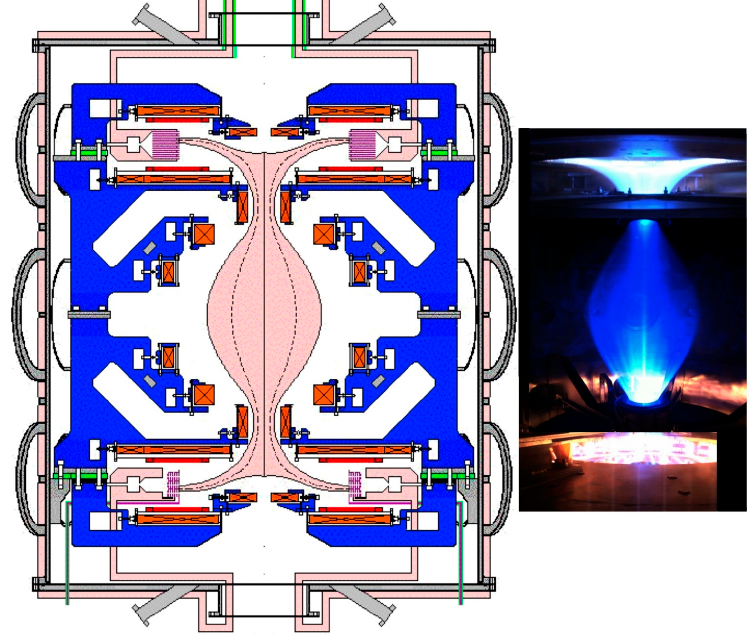
Figure 19. Comparison between the centerpost expected from the calculations and the shape obtained during the experiments (the slight differences are due the different perspectives and image superimpositions).